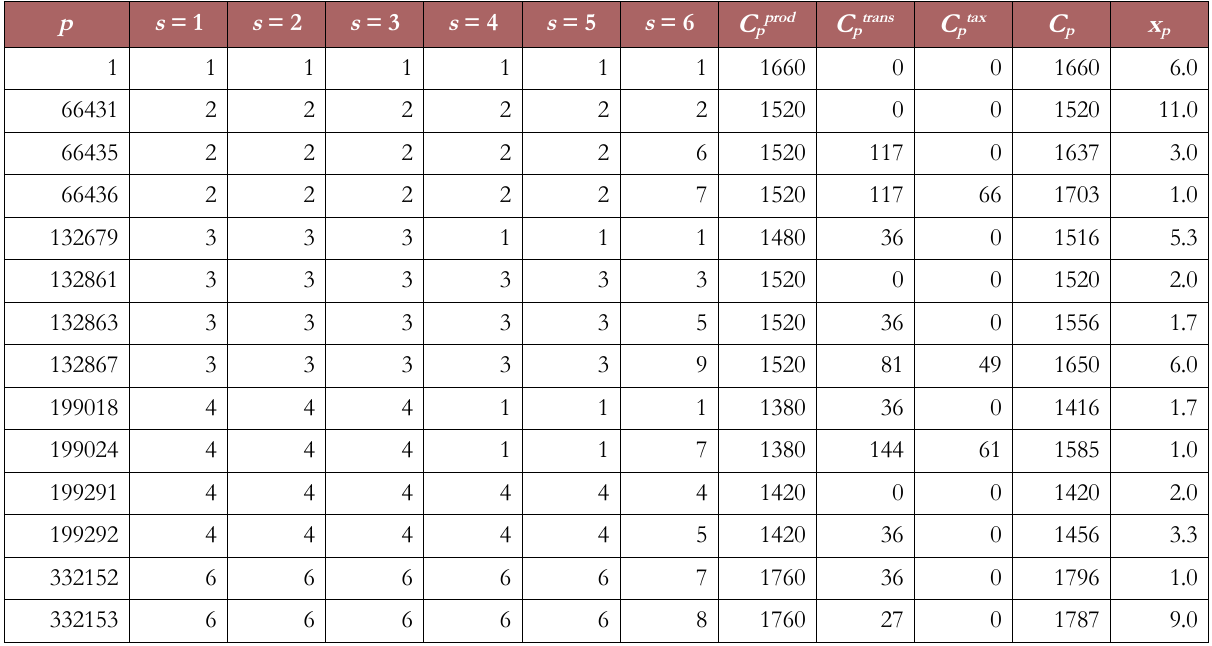
Table 7. The list of non-zero flows for total cost minimization